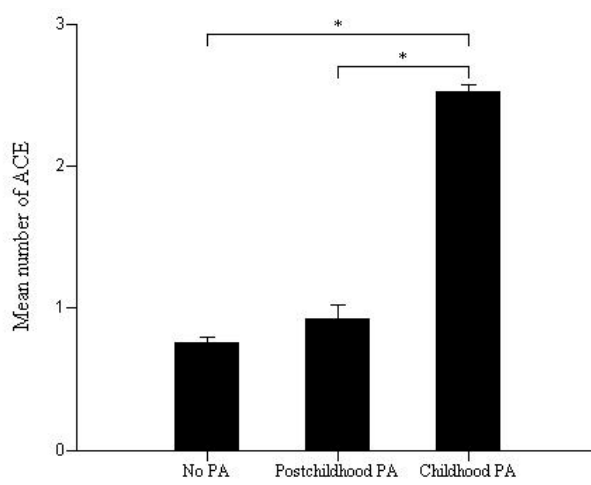
Figure 1. Comparisons of the number of adverse childhood experiences among the groups with childhood physical abuse, with post-childhood physical abuse, and without physical abuse (* p < 0.01).